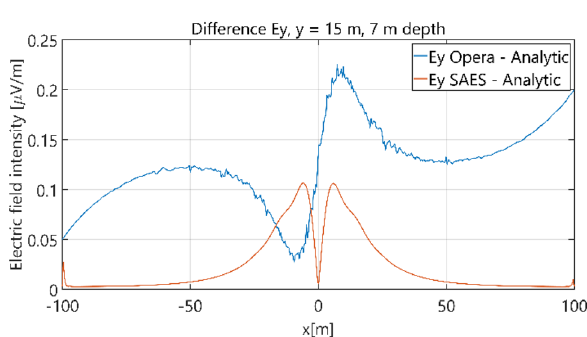
Figure 27. Distribution of differences between E y values obtained from Opera (FEM) and SAES (BEM) mdoels and the analytical model ( y = 15 m, z = − 7 m, case